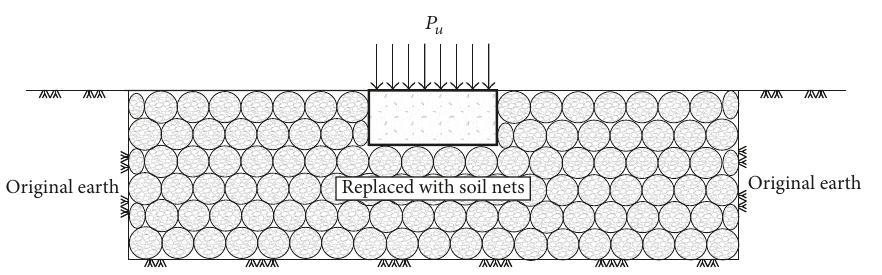
Figure 6: Schematic diagram of a foundation with soil nets